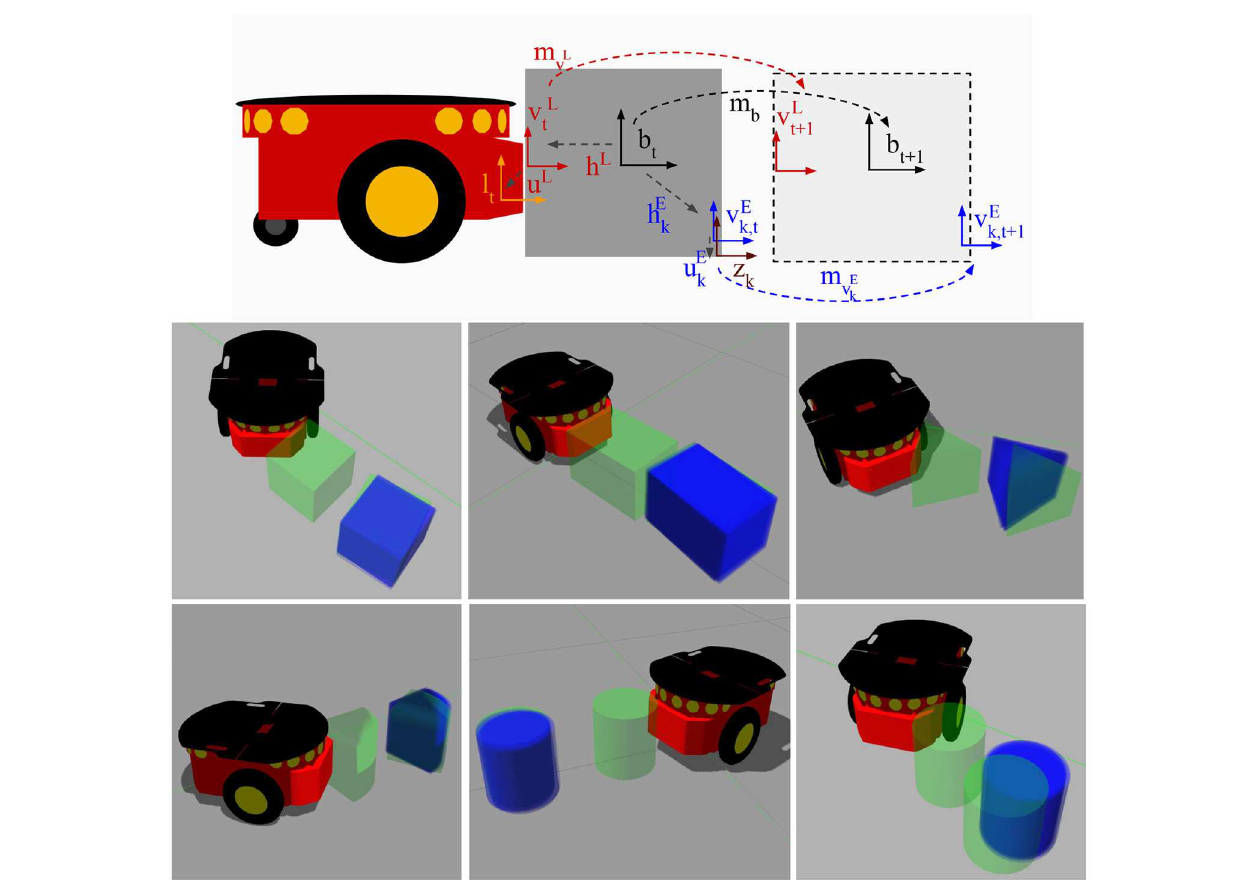
FIGURE 9 | (Top) graphical representation of the feature-based predictors for push operations. The global motion of the object after a push is described by the rigid body transformation m b . This transformation is unknown to the robot. However, the robot can estimate it by learning a set of local predictors for the motions m υ L and m υ E , for k = 1, ... , N E . The rigid body transformations h L and h E k describe the estimated contacts on the object’s surface w.r.t. the estimated global frame of the k object, b . Since the object is assumed to be rigid, this relation does not change over time, thus once the local motions m υ L and m υ E estimated by using the relations h L and h E k . (Bottom) resulting predictions. initial object pose (green, in contact with robot), true final object pose (green, displaced), and predictions (blue). Courtesy of Stüber et al.